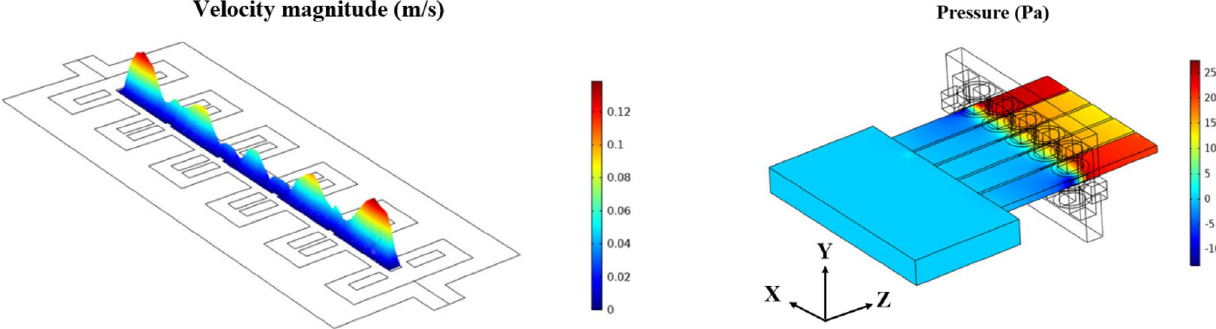
Fig. 18 The 3D contour of the pressure variations and velocity once all the arrays were